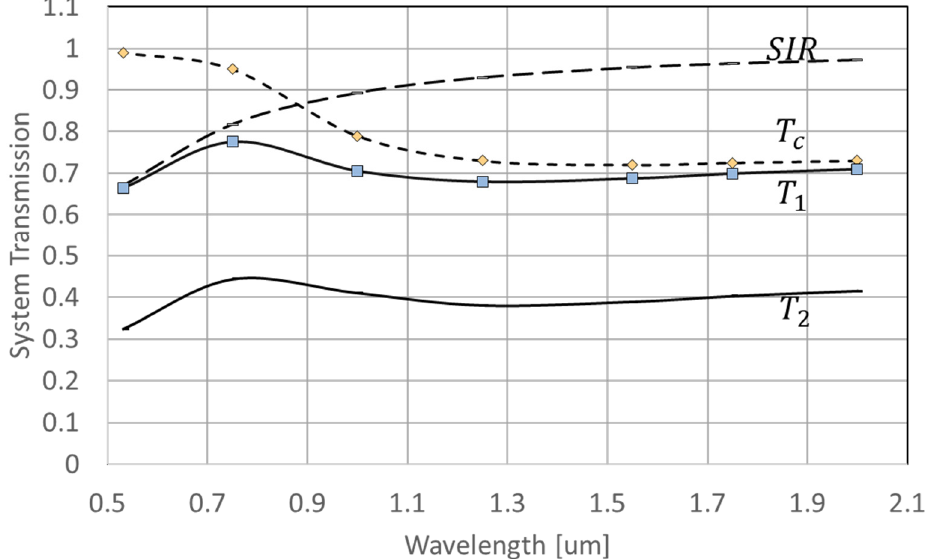
Figure 8. System transmission of single modulation ( T 1 ) and dual modulation ( T 2 ), plotted as a function of wavelength. The system transmission is a product of cover glass transmission ( T C ) and Strehl intensity ratio ( SIR ).